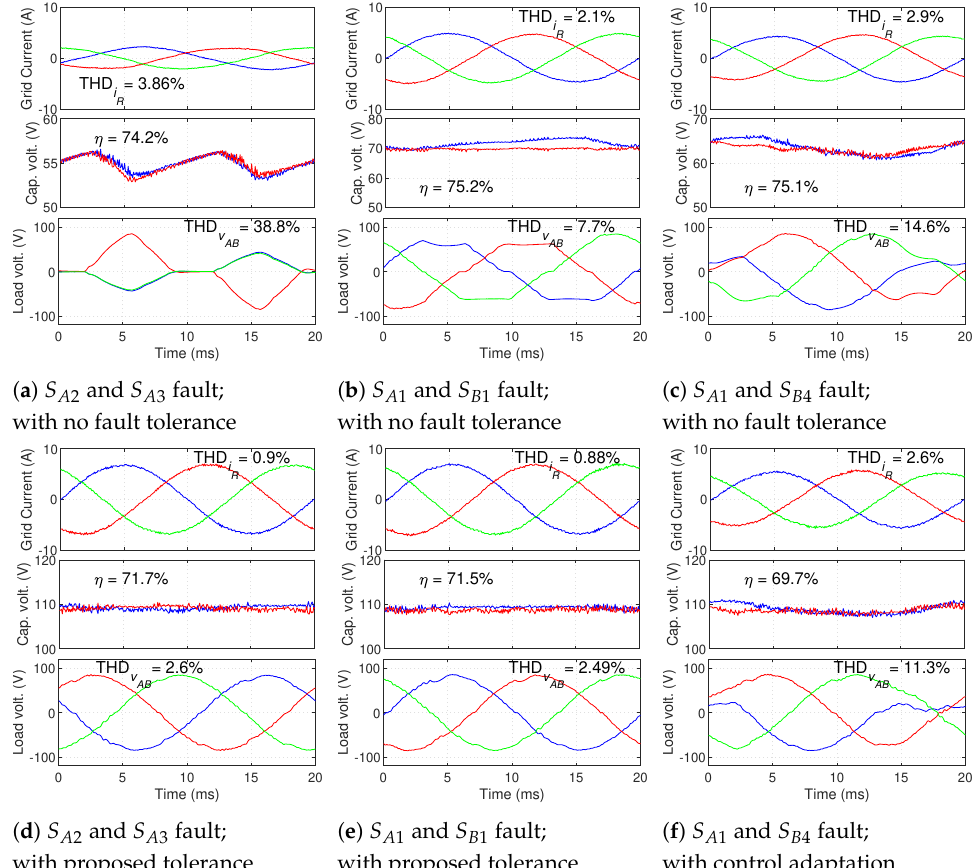
Figure 23. Steady-state operation after several multiple LSC faults, with and without corrective